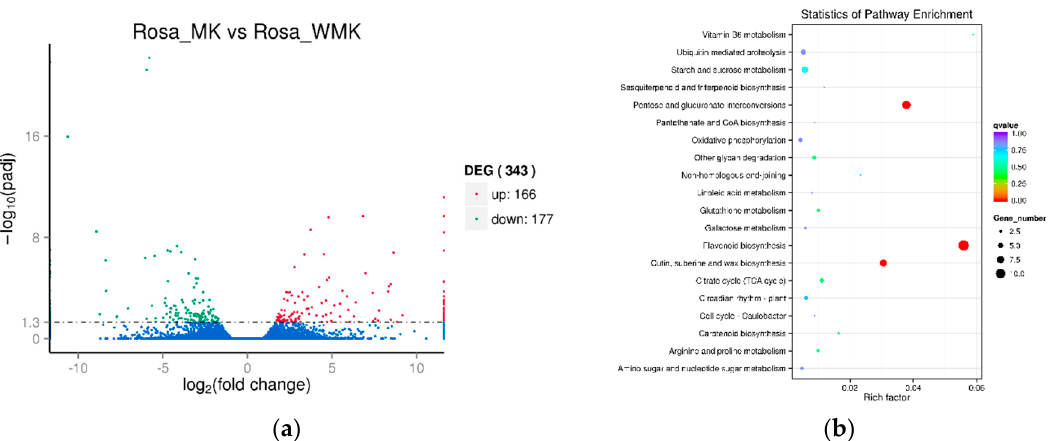
Figure 3. Differentially expression genes ( a ) and their KEGG enrichment ( b ) in the petal of two rose varieties. Rosa ’MK’ and Rosa ’WMK’ indicate Rosa ‘Margo Koster’ and Rosa ‘White Margo Koster’.